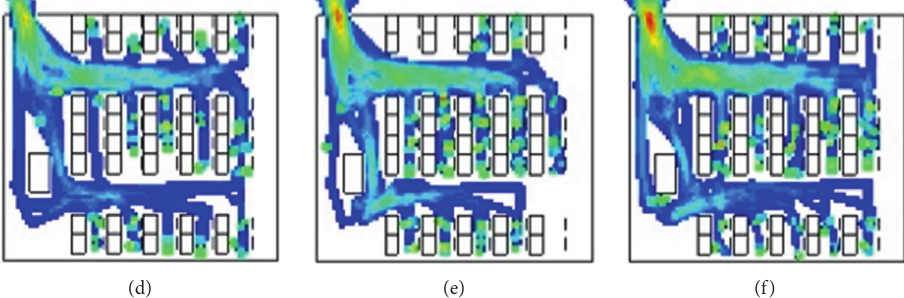
Figure 12: Flow size-based space use ratio under orderly distribution conditions. The space utilization illustrates the space using of pedestrians in an emergency. (a) 10. (b) 15. (c) 20 (d) 25. (e) 30. (f)